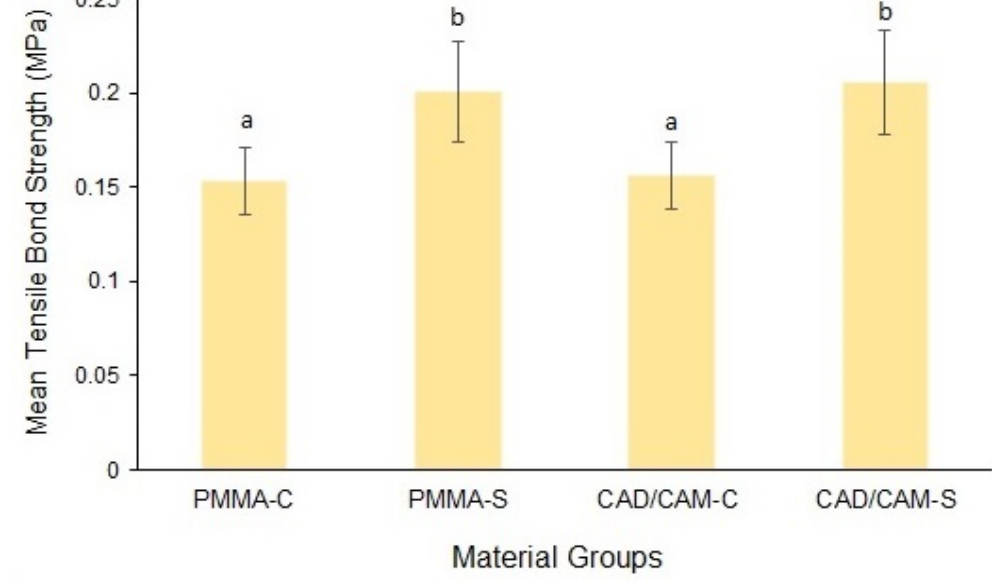
Figure 4. Mean tensile bond strength of the material groups. Bars indicate standard deviation.